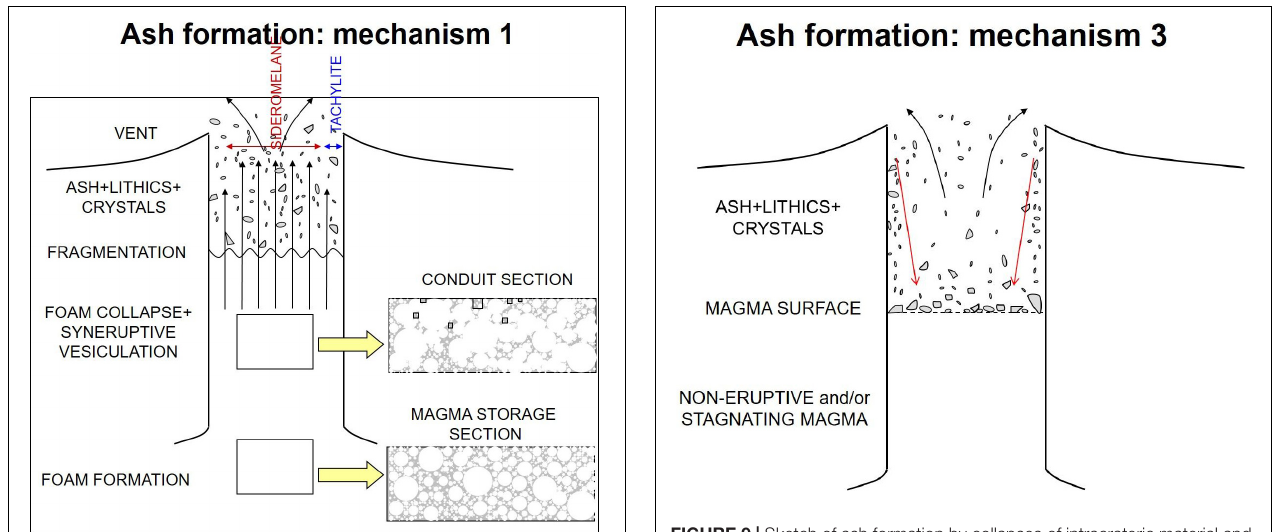
FIGURE 9 | Sketch of ash formation by collapses of intracrateric material and conduit lining (mechanism no. 3). Red arrows indicate collapsing material. Not to scale. See text for further